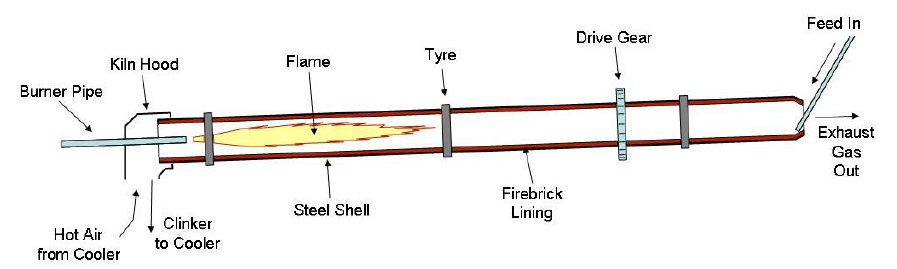
Figure 1. Schematic representation of a direct-fired counter-fed rotary